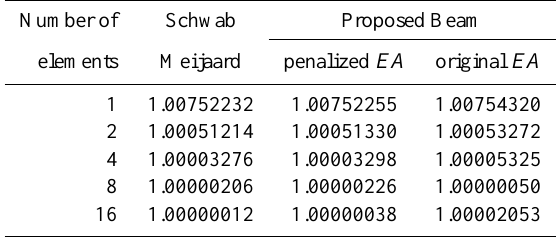
Table 4. The ratio of the numerical to the theoretical buckling load F num /F th in case of Euler buckling, Sect. 6.5, compared to the results of Schwab and Meijaard (2009). Note, that the ratio F num /F th goes up after using 8 elements when using the original value for EA , which is due to the fact, that the numerical buckling loads could only be determined by solving an eigenvalue problem for the deformed system. A second test for a stiffer value of EA showed order 4 convergence. Schwab Proposed Beam